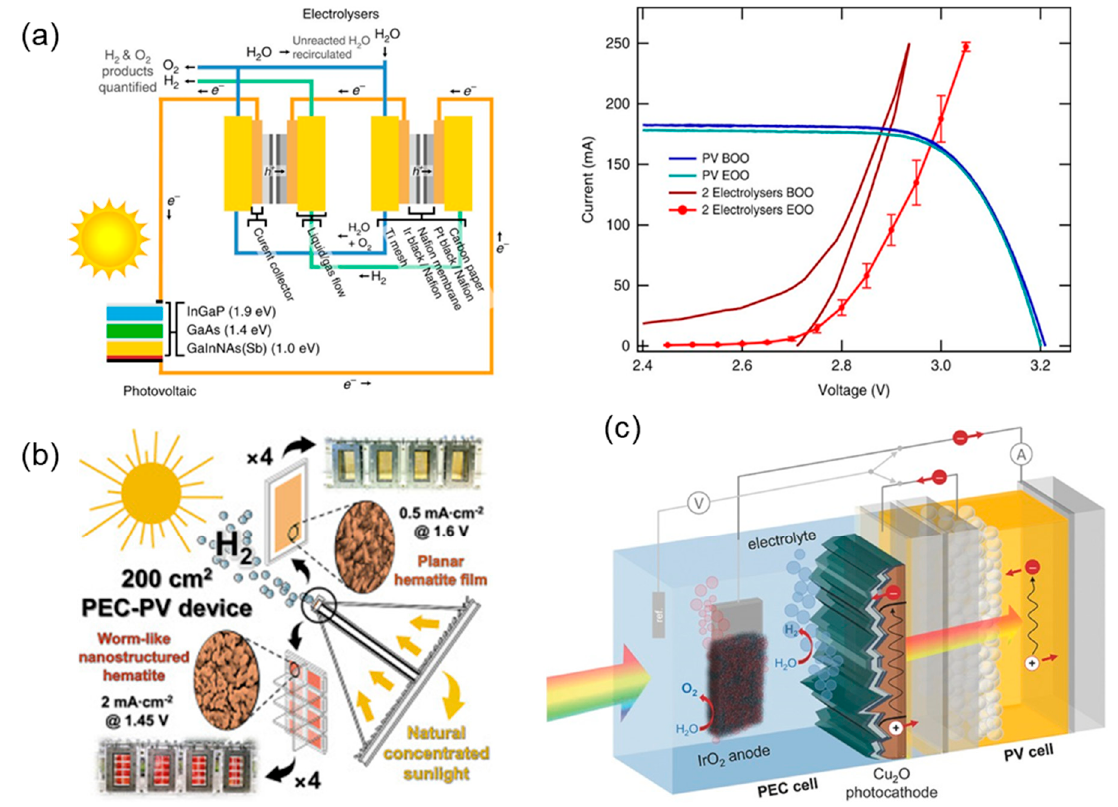
Figure 10. ( a ) Schematics of the PV–electrolysis system and performances of PV cell and proton exchange membrane (PEM) electrolyzer at the beginning and end of operation. ( b ) Illustration of CoolPEC module for solar water splitting. ( c ) Schematic of the stacked tandem cell for unbiased water splitting. ( a ) Reproduced from [100], Copyright 2016, Springer Nature. ( b ) Reproduced from [112], Copyright 2020, Elsevier. ( c ) Reproduced from [113], Copyright 2015, Wiley-VCH Verlag GmbH & Co. KGaA, Weinheim.